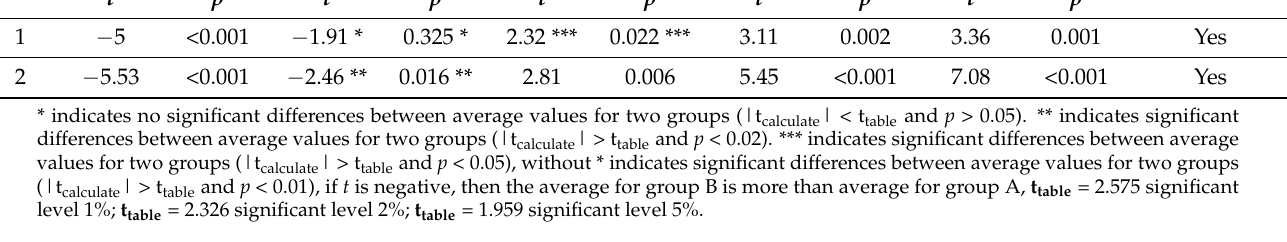
table = 2.326 significant level 2%; t table = 1.959 significant level 5%.